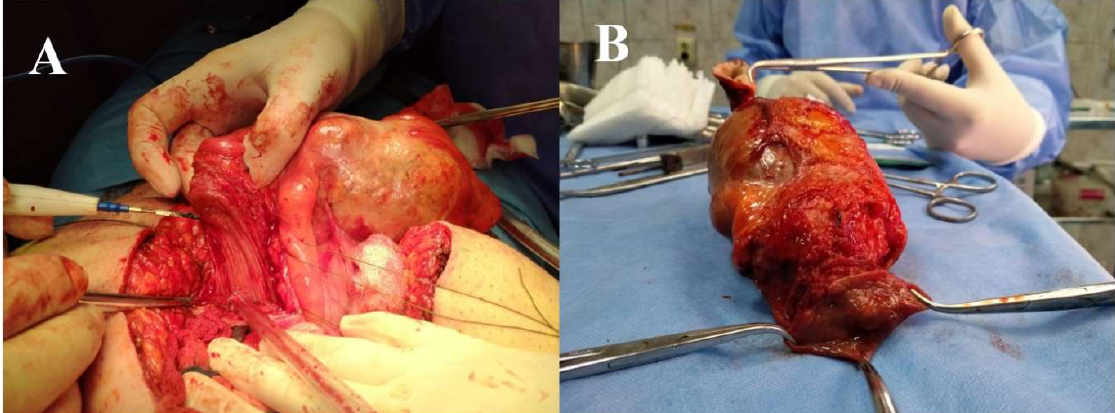
Figure 4. ( A ). Intraoperative view: The opening of the bladder in order to perform partial cystec- tomy (tumor invasion). ( B ). Radical resection of the tumor en bloc with the umbilicus and partial